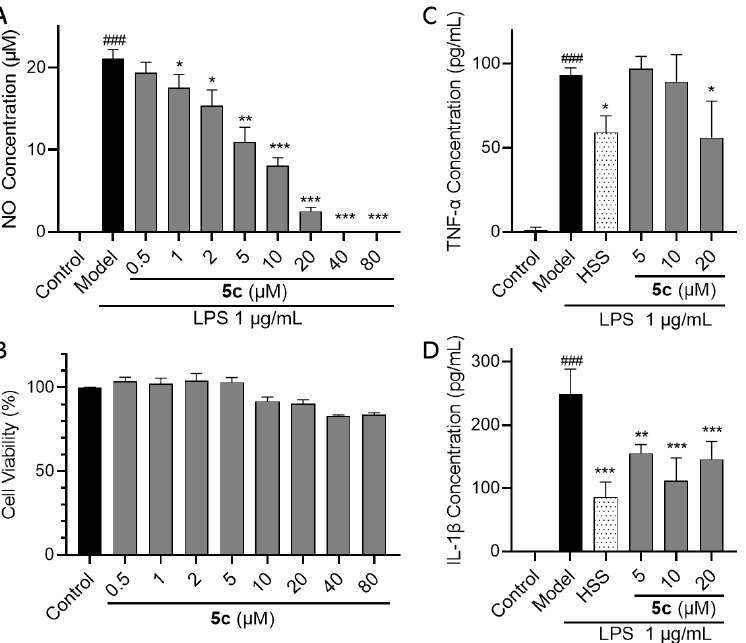
Figure 4. Anti-inflammatory effects of derivative 5c on LPS-triggered RAW264.7 macrophages. The effects of derivative 5c on ( A ) NO release, ( B ) the cytotoxicity, ( C ) TNF- α , and ( D ) IL- 1β secretion. The cells were evaluated following a ( A , D ) 24 h or ( C ) 6-h treatment with 5c and LPS and ( B ) after 72-h treatment with 5c . Data are expressed as the means ± SD ( n = 3): ### p < 0.001 vs. control; * p < 0.05, ** p < 0.01, *** p < 0.001 vs. model.